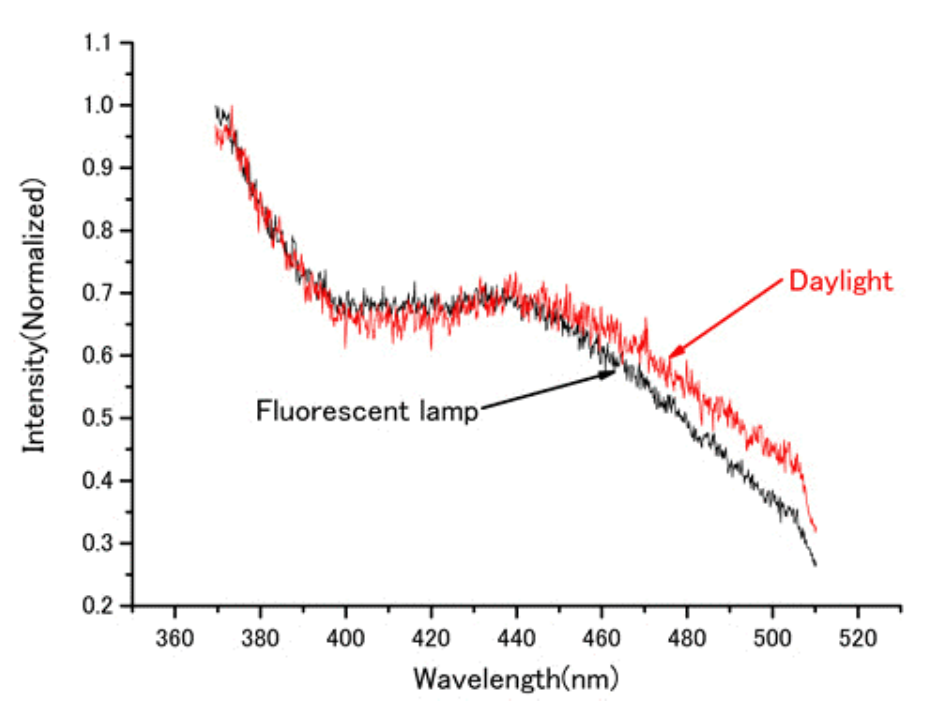
FIGURE 14 . Fluorescence spectra of peak B after being left 14 days in ambient